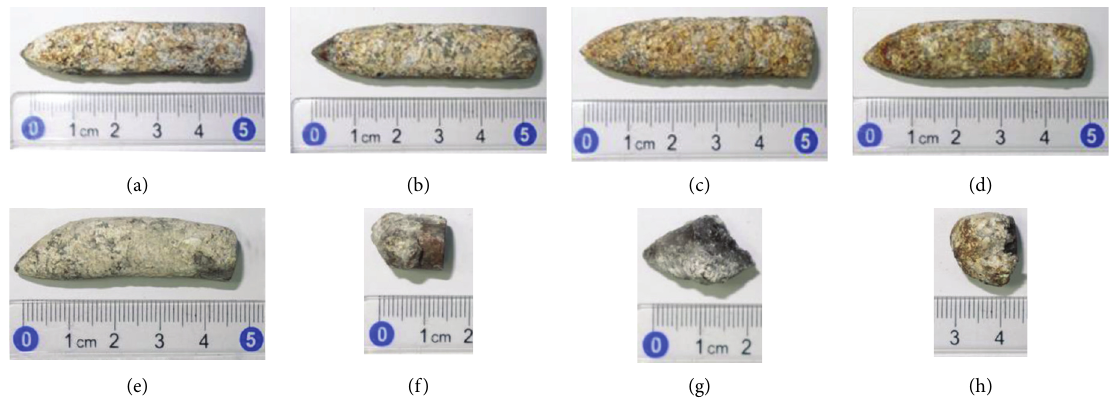
Figure 8: Posttest projectiles at different impact velocities. (a) υ � 1654m/s. (f) υ υ 0